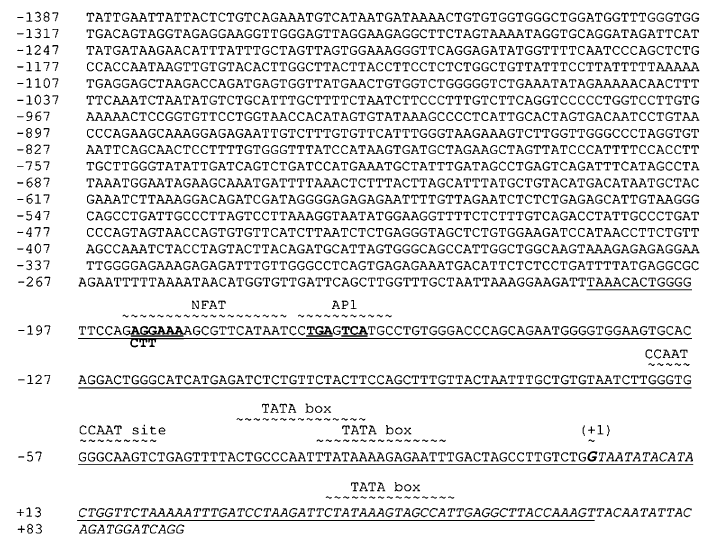
Fig. 2A. The nucleotide sequence of the promoter G region. The promoter G sequence (Genbank Accession No: AF473808) is indicated by a single underline. The transcriptional initiation site is in bold and assigned by + 1. Putative binding sites for transcriptional factors were predicted by using the Matinspector program (Genomatix, Germany) and are indicated by labels above the sites.